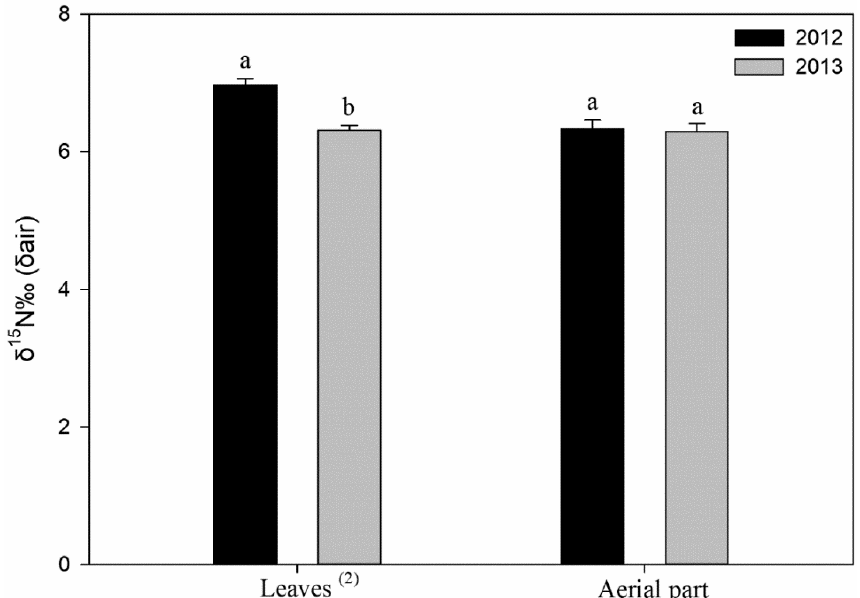
Figure 5. 15 N natural abundance of leaves and aboveground biomass without ears of green corn.